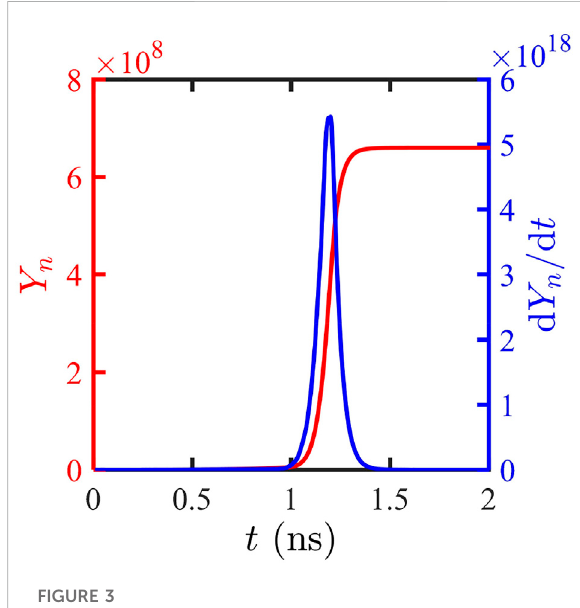
FIGURE 3 Neutron yield (red line) and generation rate integrated over the whole domain (blue line) evolve over